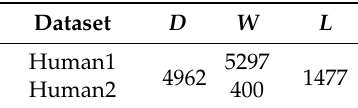
Table 5. The statistic of two human